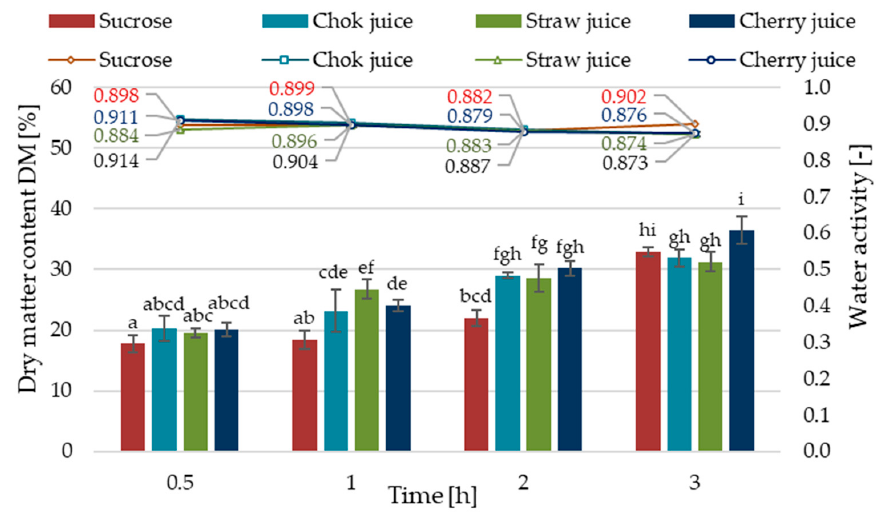
Figure 2. Effect of the type of osmotic agent (sucrose and fruit concentrates) on the dry matter content and water activity of osmodehydrated strawberries. Different letters above columns show the statistical difference ( p < 0.05).